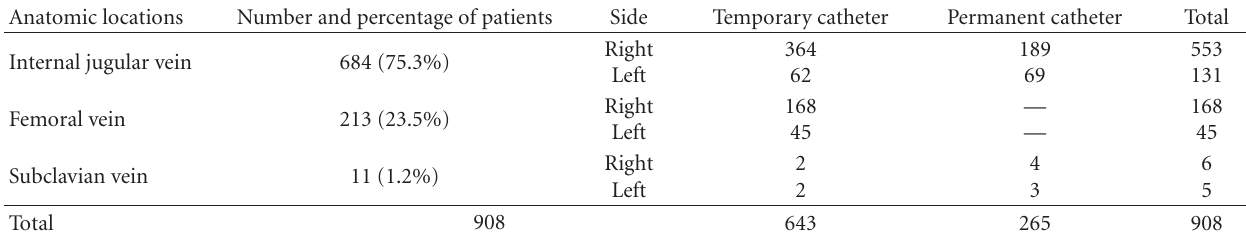
Table 1: The anatomic locations of the